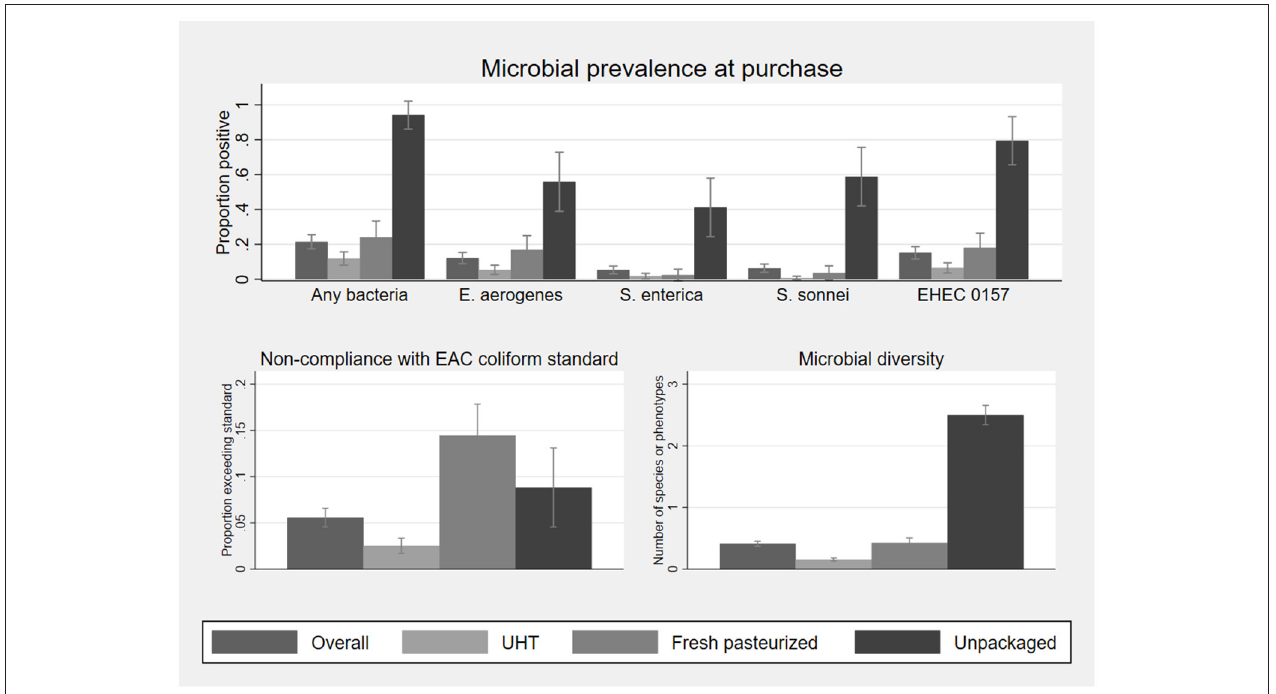
FIGURE 2 | Microbial prevalence, compliance with EAC coliform standards for pasteurized (UHT, fresh pasteurized) and raw (unpackaged) milk, and microbial diversity, of 395 fluid milk samples collected at point of purchase, by milk type. Sample sizes by milk type are 278 UHT, 83 fresh pasteurized, and 34 unpackaged. Statistics on which this figure is based, as well as mean bacterial concentration among positive samples, are shown in Supplementary Table S5 . EHEC 0157 was classified based on phenotype and not validated as a human pathogen. Error bars represent 95% confidence intervals.